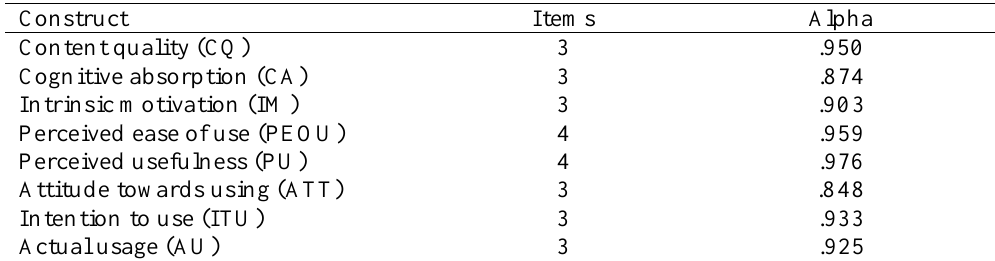
Reliability Coefficient for Individual Variables